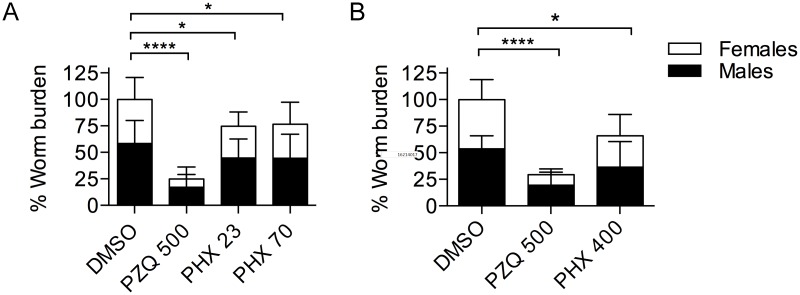
PHX activity on worm burden in mice infected with S. mansoni.The histograms show the % of worm burdens in mice treated with DMSO, PZQ and PHX. In white is represented the female and in black the male worm burden contribution. Worm count data are represented as a percentage of the mean worm count ± SD of experimental control (DMSO) group. In Figure A and B the average of worm burden percentages of mice treated with the same compound and at the same dose regimen are representative respectively of four and two independent experiments. * indicates p values < 0.05 and **** indicates p values < 0.0001.